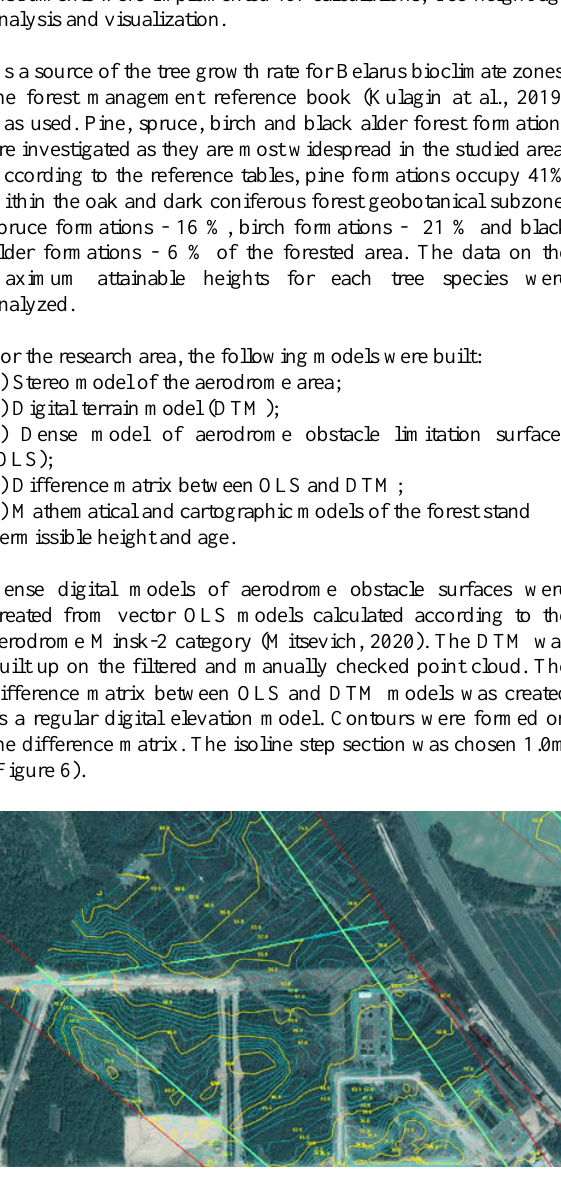
Figure 6 . Permissible obstacle height contours with 1.0m step section